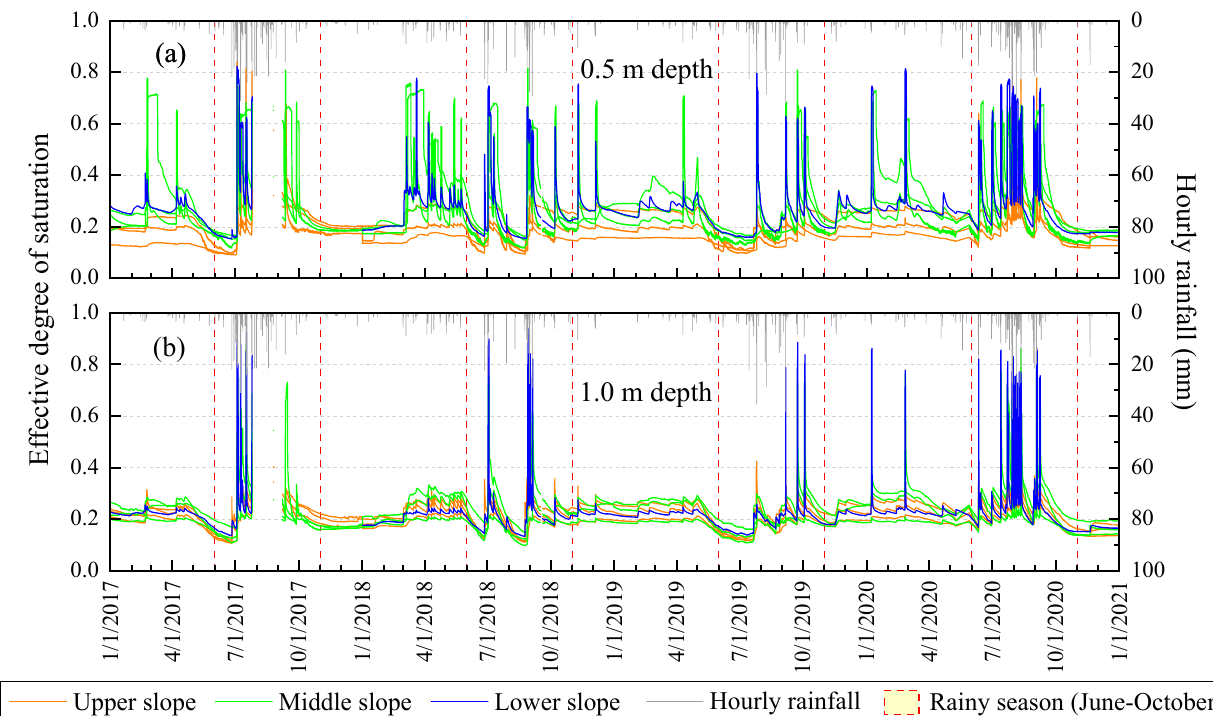
Figure 8. Effective degrees of saturation measured at the soil depth of ( a ) 0.5 m, and ( b ) 1.0 m, during 4 y (2017–2020) at the Songnisan landslide monitoring station.